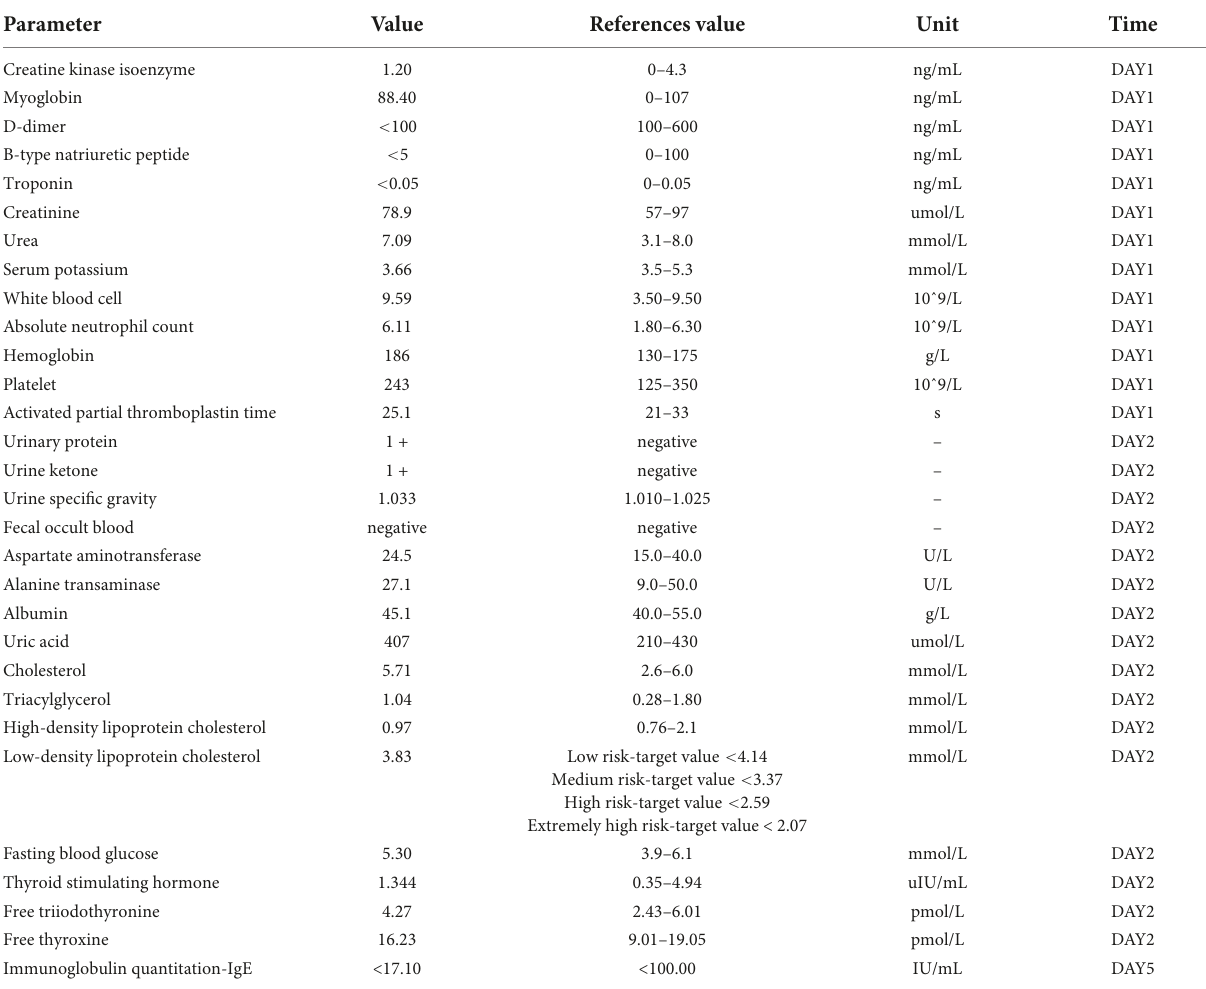
TABLE 1 The patient’s laboratory data according to the time line of the